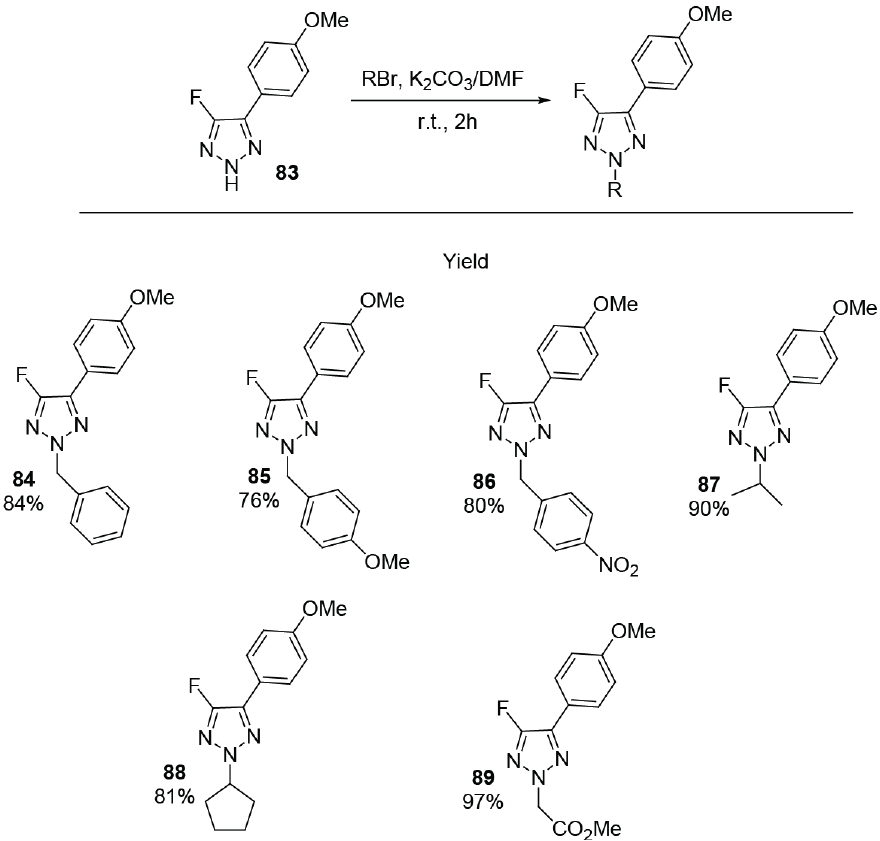
Figure 15 - highly N 2 regioselective Alkylation of